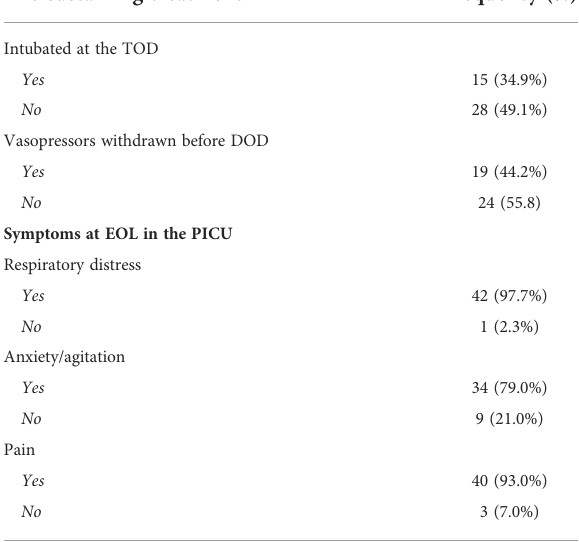
TABLE 4 Frequency of life-sustaining treatments withdrawn at the end of life and symptoms experienced. Life-sustaining